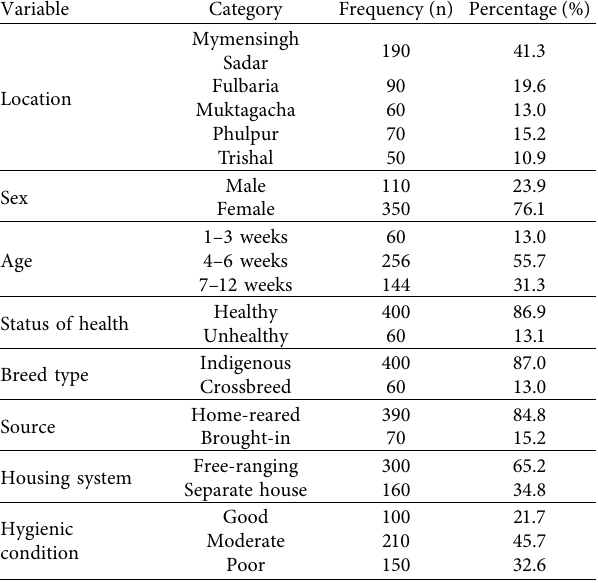
Table 2: Frequency distribution of demographic characteristics ( N �